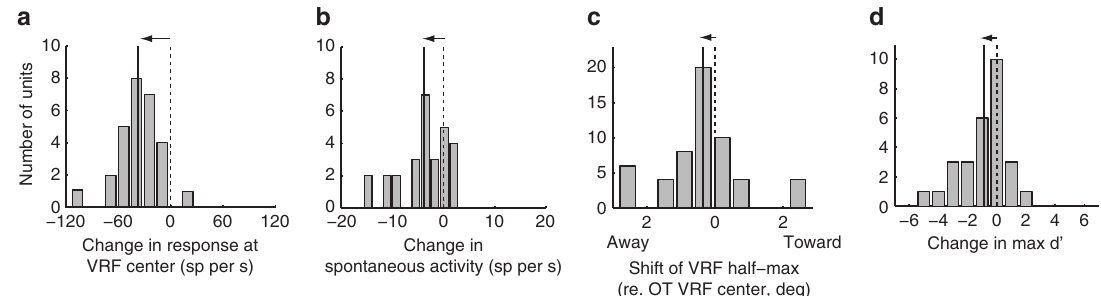
Figure 3 | Effect of Ipc blockade on unit responses at aligned OTsites. The data compare single-unit responses in the OTmeasured before versus during Ipc blockade, for aligned OT–Ipc pairs. ( a ) Change in response rate measured at the VRF centre ( n ¼ 28). ( b ) Change in the spontaneous rate ( n ¼ 28). ( c ) Shift in the half-max locations of the VRF ( n ¼ 56). ( d ) Change in spatial resolution, measured as max d 0 ( n ¼ 28). Solid vertical line: mean value; horizontal arrow indicates significant shift from zero ( P o 0.05; paired t